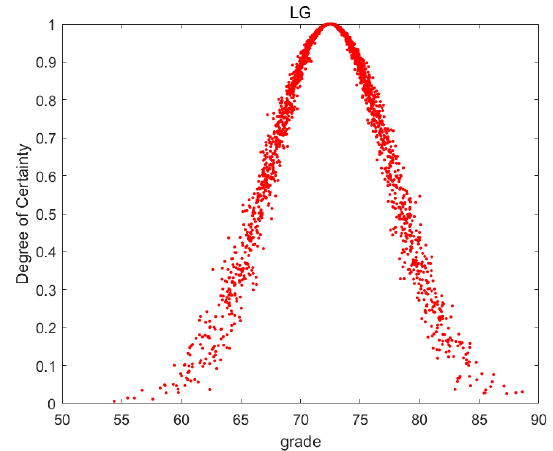
Figure 5. Cloud image of TM.